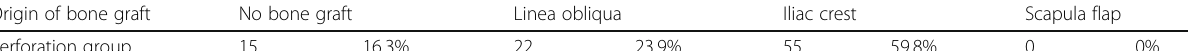
Table 2 Origin of bone graft Origin of bone